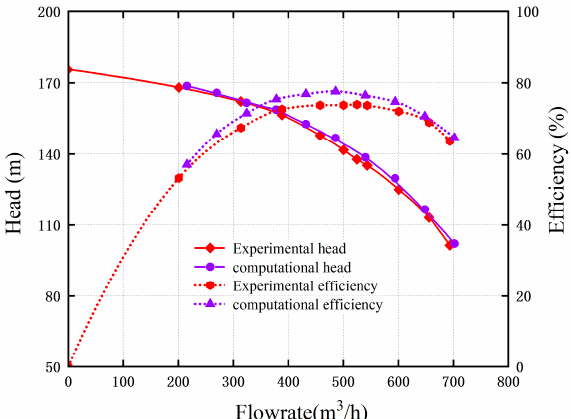
Figure 5. Comparison of experimental results and numerical calculation results.